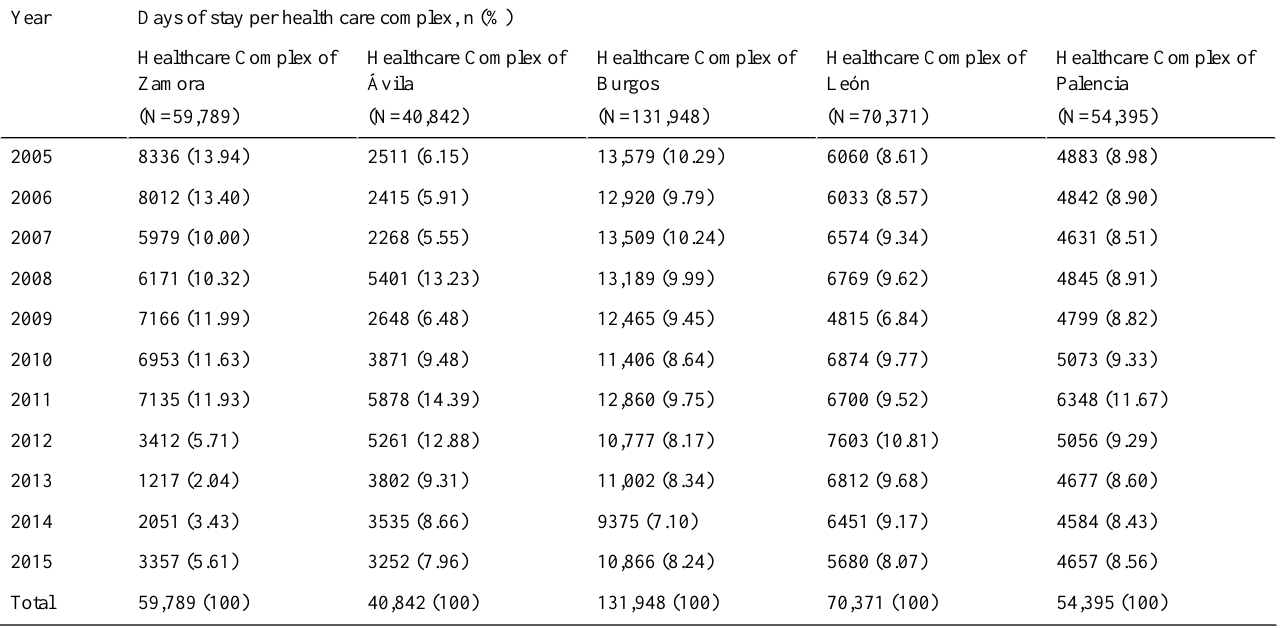
Table 1. Total number of days of stay per admission year for hospital centers in Zamora, Ávila, Burgos, León, and Palencia. Days of stay per health care complex, n